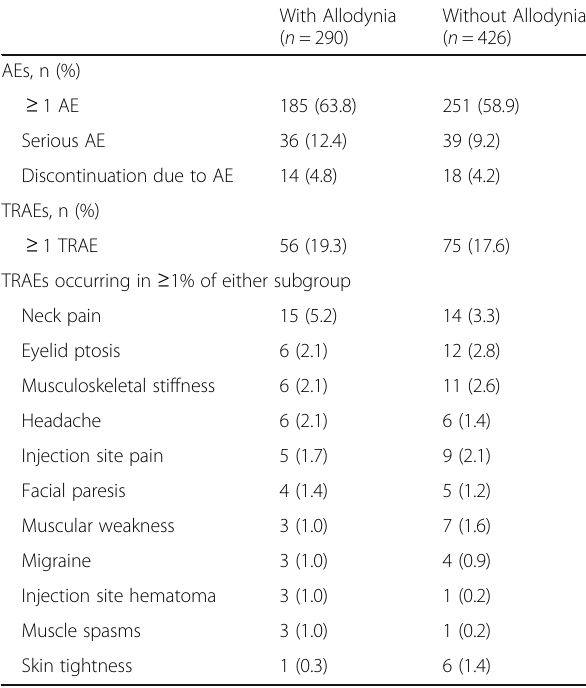
Table 2 Summary of Adverse Events Occurring in Patients With and Without Allodynia